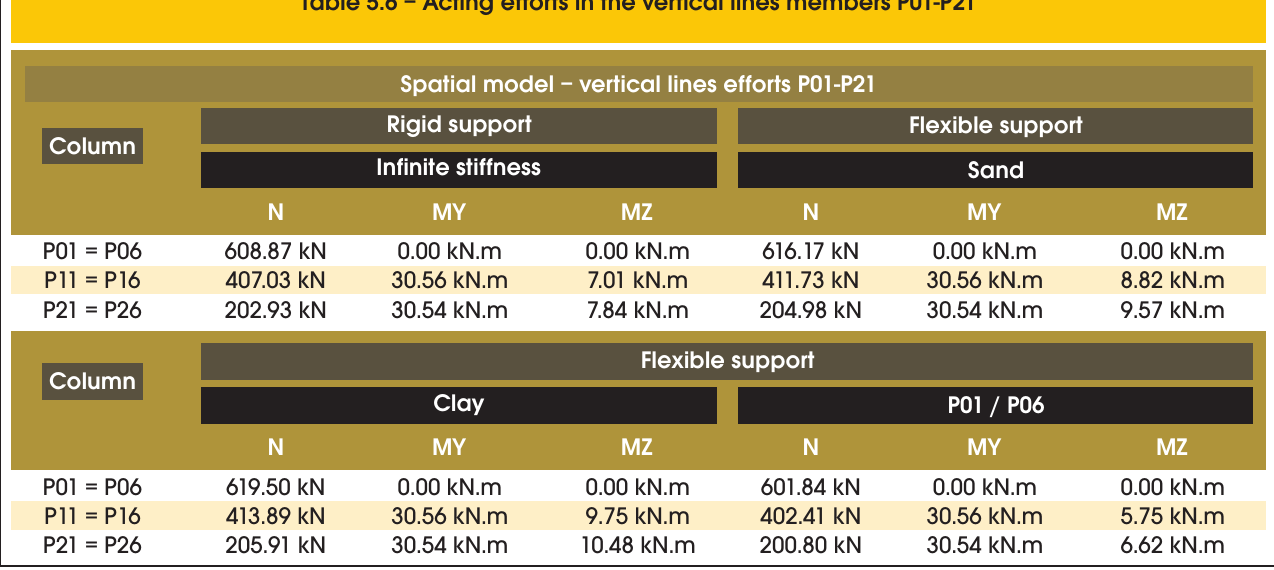
Table 5.6 – Acting efforts in the vertical lines members